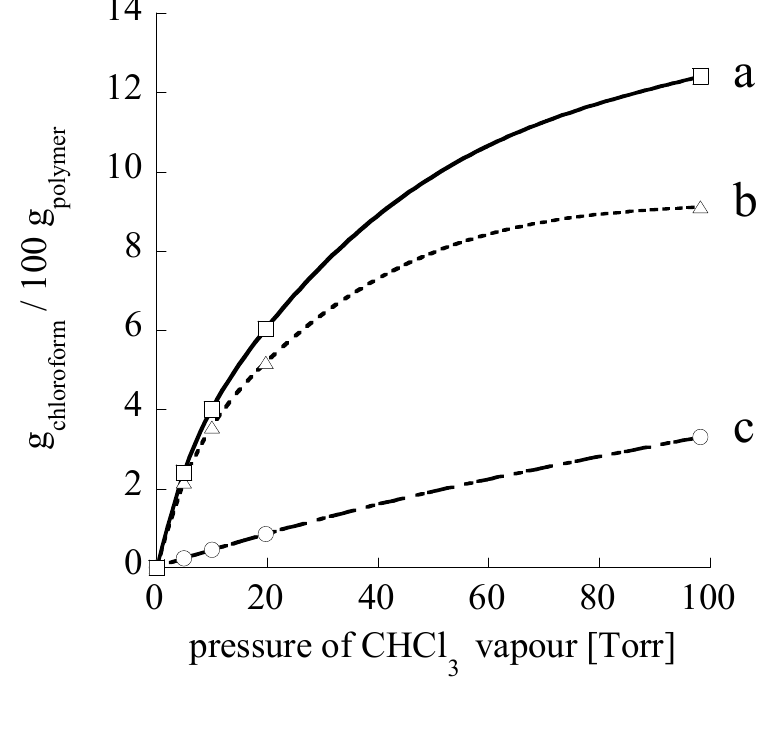
Figure 4. Chloroform vapour sorption isotherms in s-PS δ -form at 35 °C. (a): overall sorption for semi-crystalline sample. (b): calculated contribution of the crystalline phase. (c): calculated contribution of the amorphous phase. Data taken from ref [75]. Lines are drawn to guide the